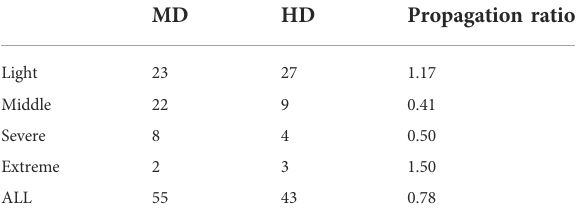
TABLE 3 Frequency and propagation ratio of meteorological and hydrological droughts in different